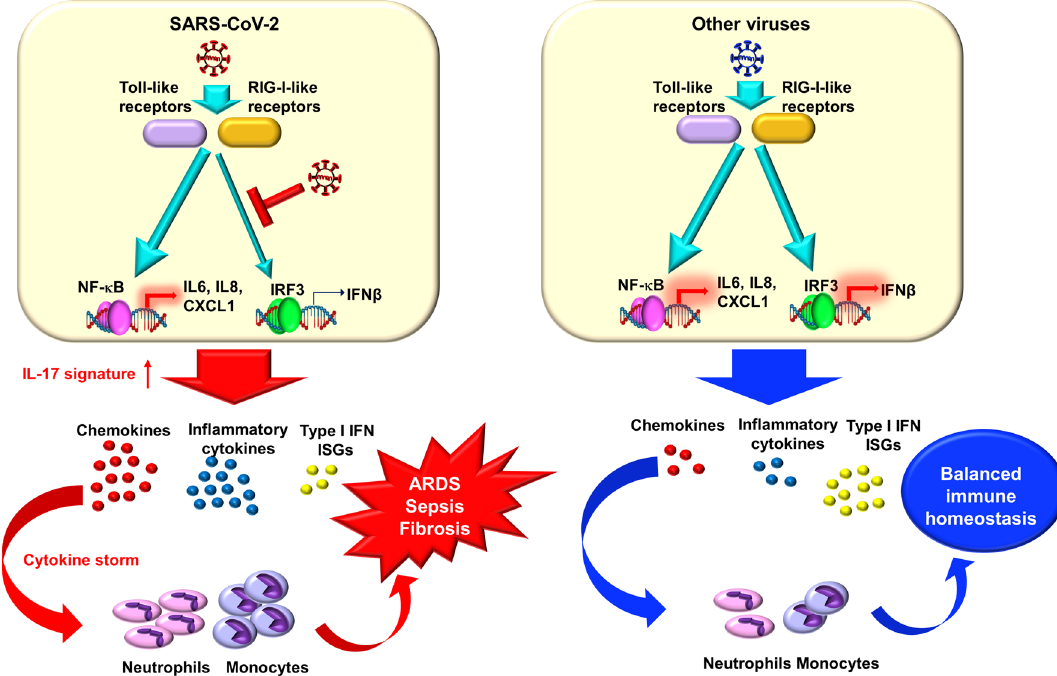
Figure 7. Summary of transcriptional differences among SARS-CoV-2 and other respiratory viruses. SARS- CoV-2 infection initiates a predominant IL-17 enriched chemokine transcriptional response whilst producing a low to moderate antiviral response by impairing interferon regulatory factors driven transcriptional process. This results in disproportionate immune response and recruitment of innate immune cells that ultimately leads to complications such as ARDS, sepsis or fibrosis in COVID-19 patients, On the other hand, other respiratory viruses trigger both inflammatory and antiviral transcriptional response in host cells, and thereby maintain a steady immune